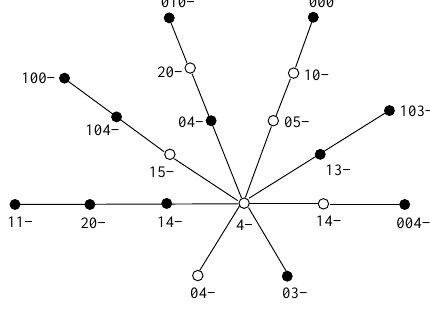
Figure 5: An ID-coloring of a starlike